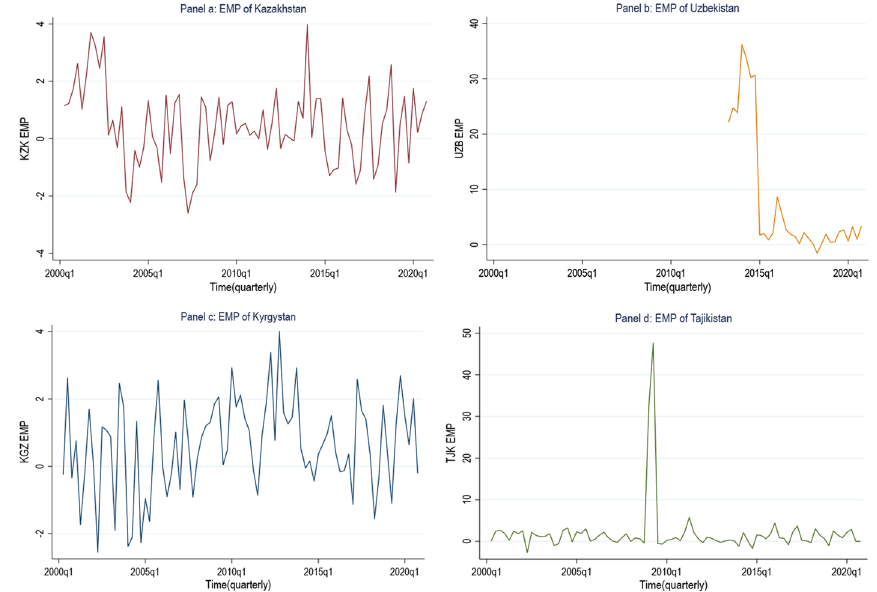
Fig. 4 The exchange market pressure index of four